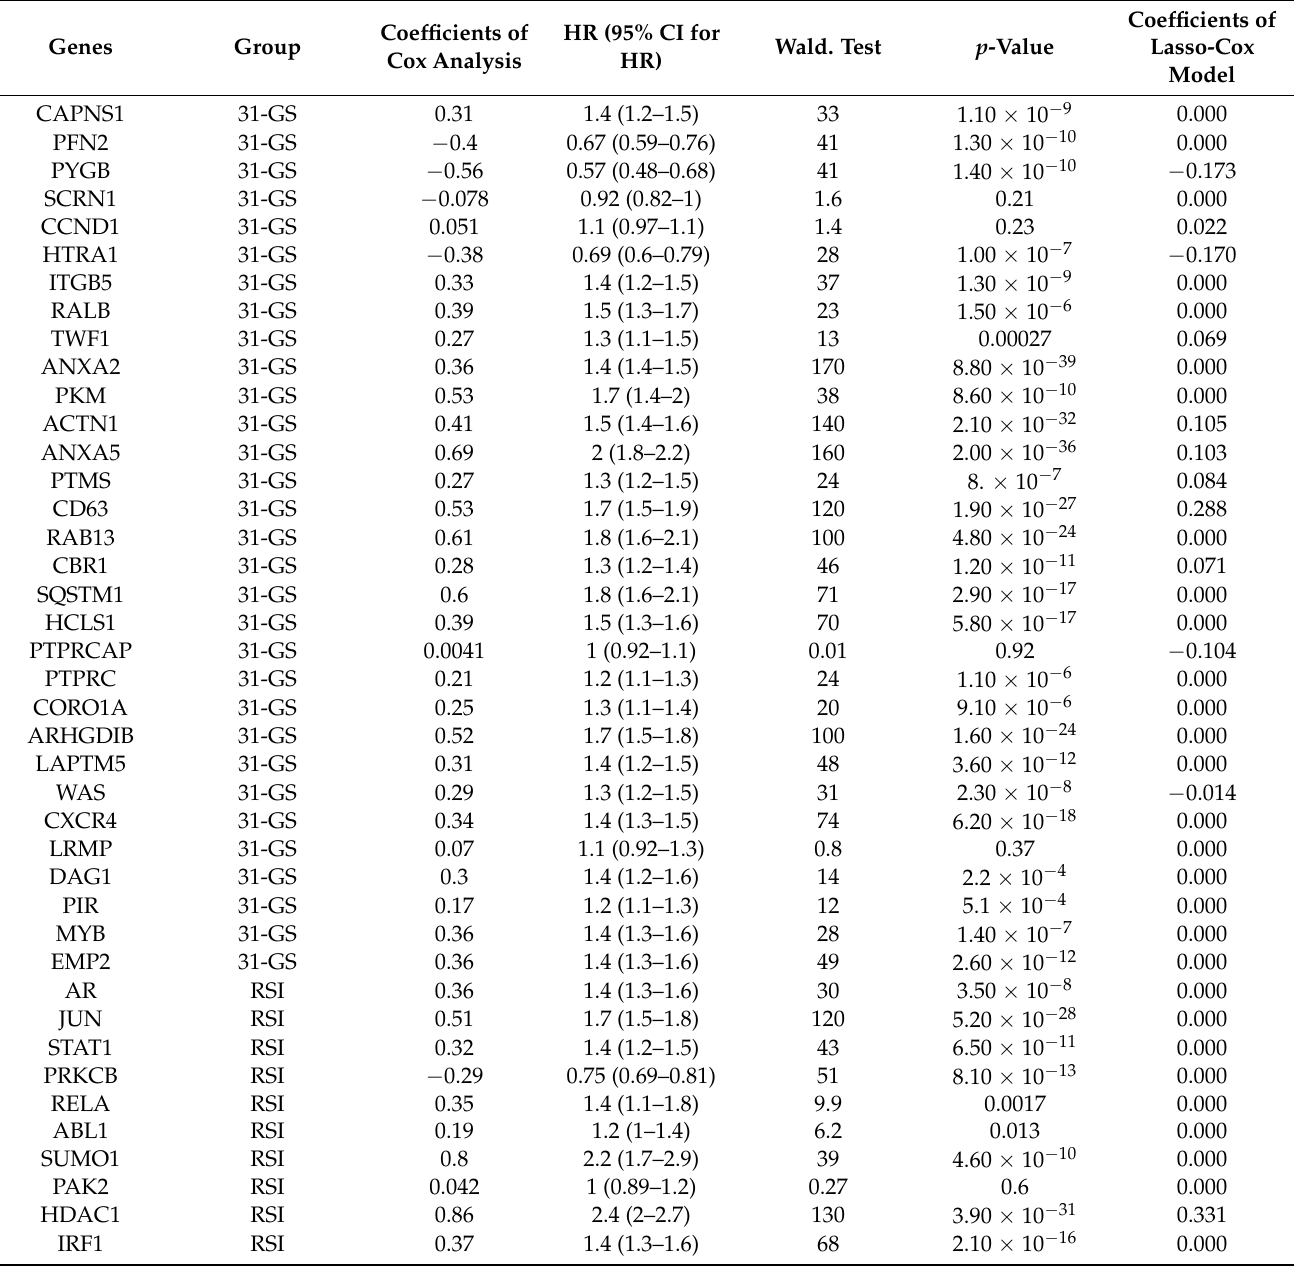
Table 2. Radiosensitivity index (41-gene signature) for predicting